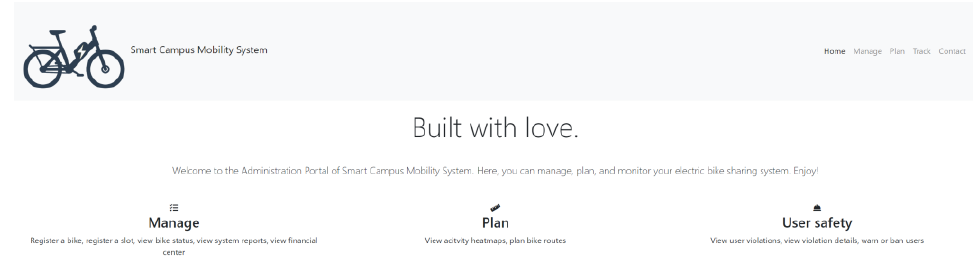
Figure 9. Main presented features for the admin